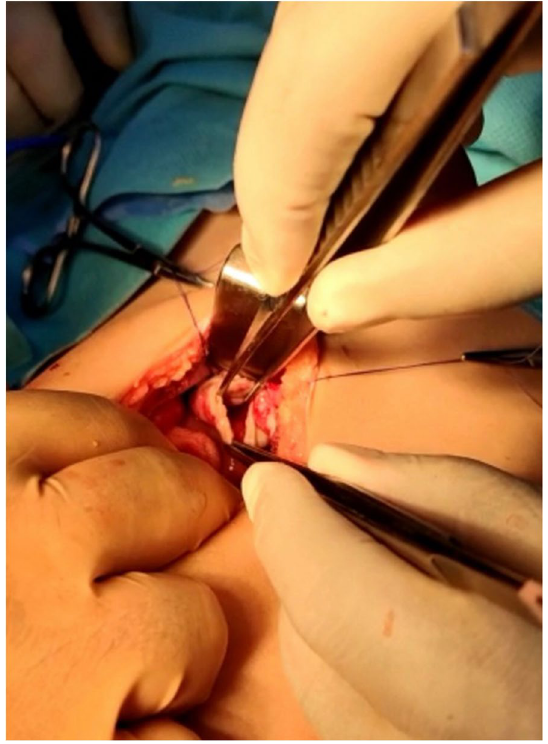
Fig. 2 An image was taken during surgery showing one of the perforations at the dome of the urinary